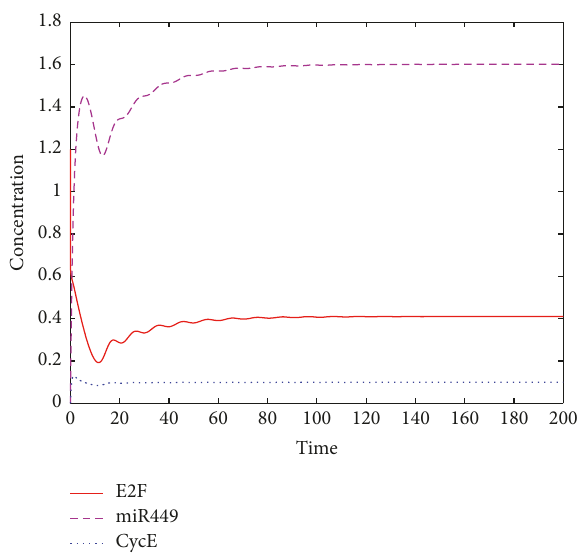
= 0, 𝑥 = 0, 𝑥 = 2 3 4 = 1.4 . 21